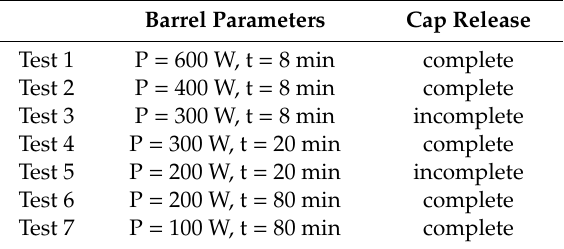
Table 3. Barrel parameters for the etching of the sacrificial layer and consequent results in terms of release for capping layers with A =